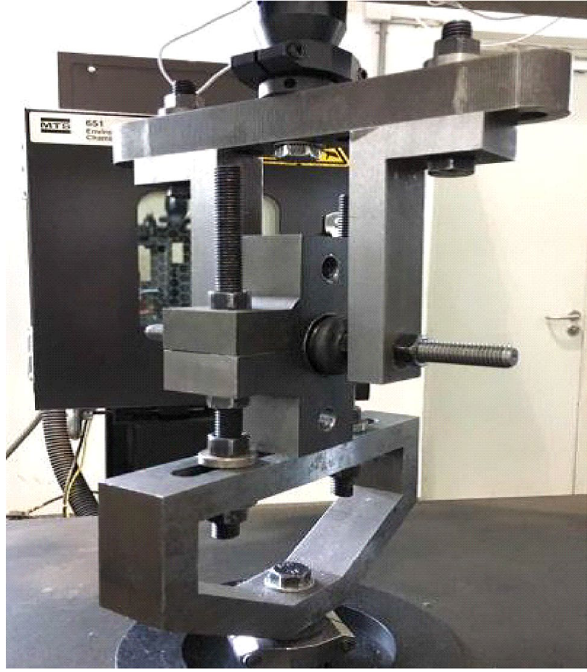
Figure 8. Elastomer test.